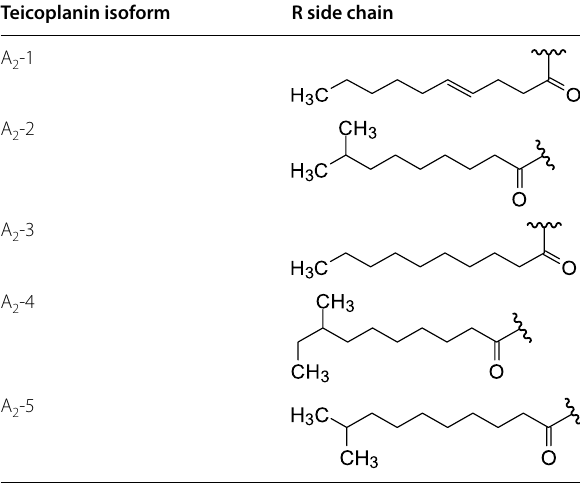
Table 2 Lipophilic side chains for the different isoforms of teicoplanin according to the nomenclature of reference [92] Teicoplanin isoform